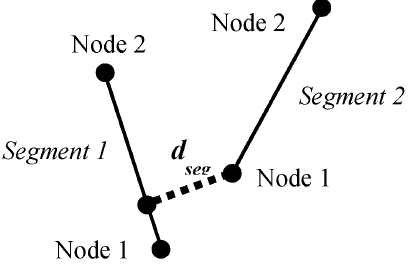
Figure 10. Tunneling path between a node and a segment.